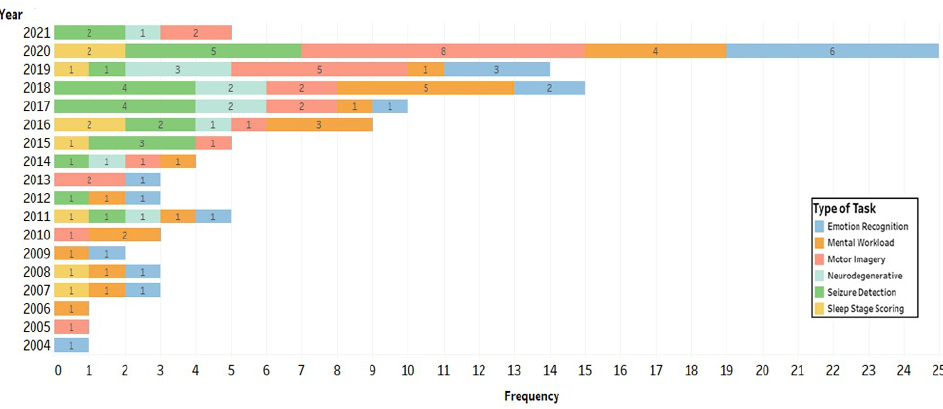
Figure 5. Temporal distribution of the number of publications per domain in each year